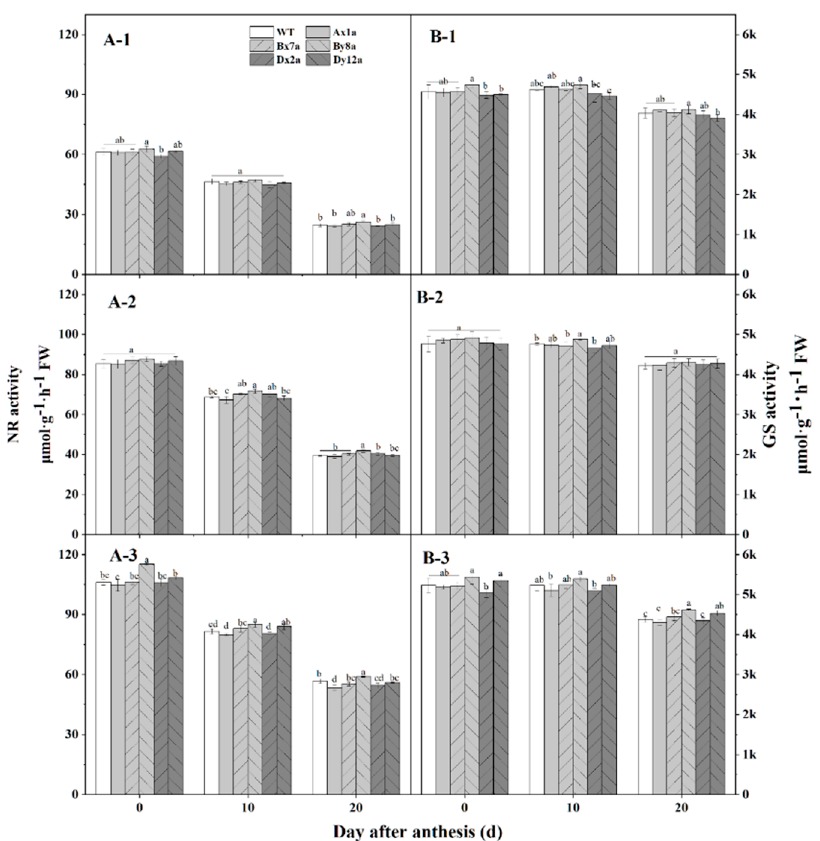
Figure 5. Changes in total nitrate reductase (NR) ( A ) and glutamine synthetase (GS) ( B ) activity in wheat lines with the absence of HMW-GS under different N treatments in 2017–2018 wheat growing season. N0: ( A-1 , B-1 ); N120: ( A-2 , B-2 ); N180: ( A-3 , B-3 ). Different letters in the same N level for different wheat lines indicate a significant difference ( p < 0.05).